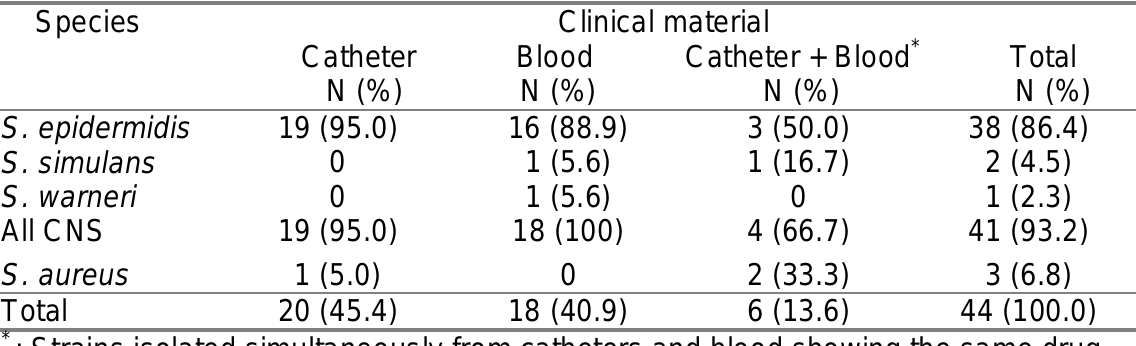
Table 2. Frequency of Staphylococcus species according to clinical material.